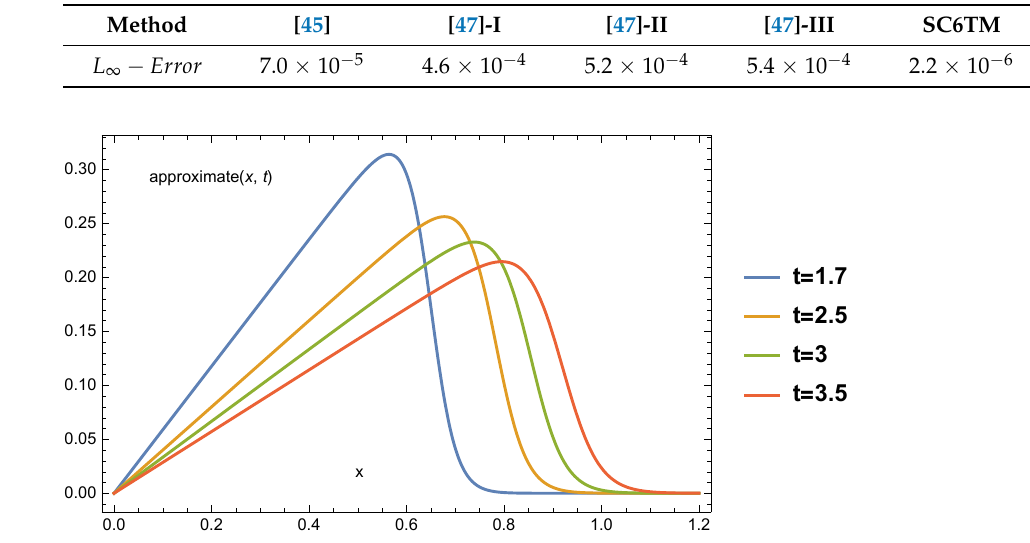
Figure 8. The approximate solutions of Example 4 for different values of t .